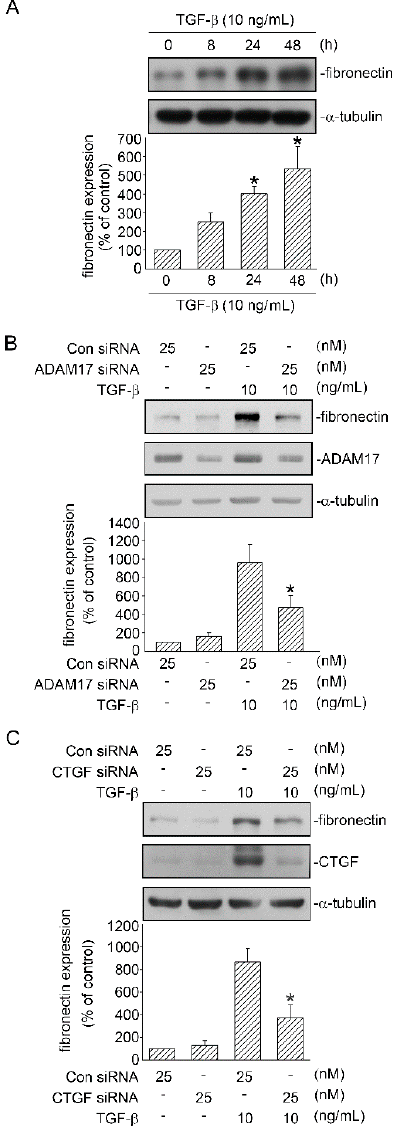
Figure 8. Involvement of ADAM17 and CTGF in TGF- β -induced FN expression in human lung epithelial A549 cells. ( A ) A549 cells were stimulated with TGF- β (10 ng / mL) for 0–48 h. FN and α -tubulin levels were detected in cell lysates through Western blotting. Data are presented as mean ± SEM of three independent experiments. * p < 0.05, compared with the control group without TGF- β treatment. ( B ) A549 cells were transfected with control siRNA (con siRNA) and ADAM17 siRNA (25 nM). After 24 h, the cells were stimulated with TGF- β (10 ng / mL) for an additional 48 h. FN and α -tubulin levels were detected through Western blotting. Results are presented as mean ± SEM of three independent experiments. * p < 0.05, compared with TGF- β plus the control siRNA group. ( C ) Cells were transfected with control siRNA (con siRNA) and CTGF siRNA (25 nM). After 24 h, the cells were stimulated with TGF- β (10 ng / mL) for an additional 48 h. FN and α -tubulin levels were detected through Western blotting. Results are presented as mean ± SEM of three independent experiments. * p < 0.05, compared with TGF- β plus the control siRNA